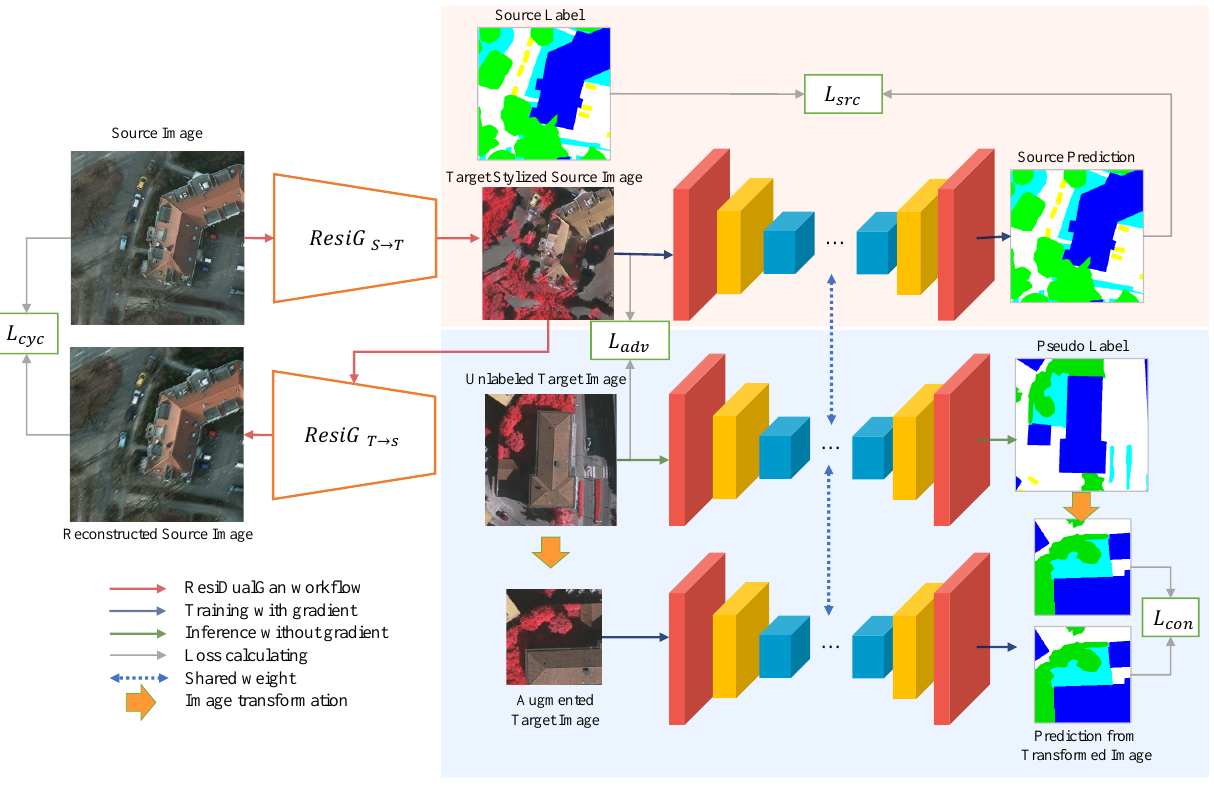
Figure 1. Overview of proposed framework. ResiG S → T and ResiG T → S are generators of the ResiD- ualGAN between two domains. L cyc and L adv are cycle loss function and adversarial loss function, respectively. L src and L con are segmentation loss function for source data and target data,